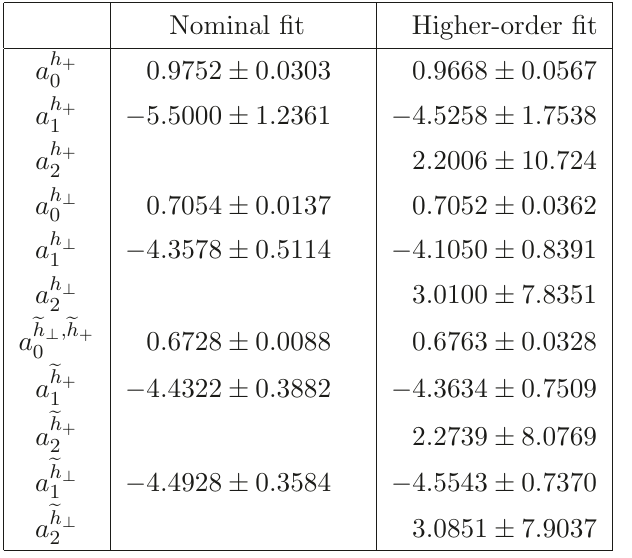
Table 2 . Results for the z -expansion parameters describing the Λ b physical limit (in the MS scheme at the renormalization scale µ = m b ). Files containing the values and covariances of the parameters of all ten Λ b